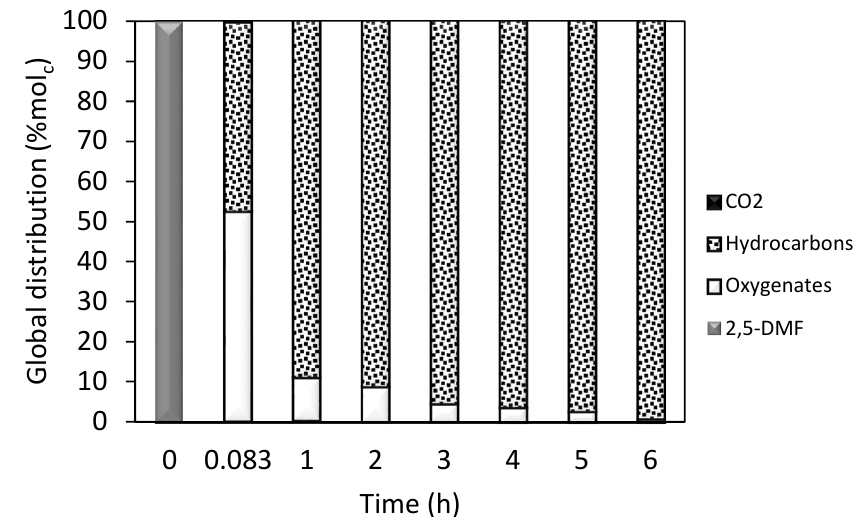
Figure 9. Carbon global distribution as a function of time during the 2,5-dimethylfuran (2,5-DMF) transformation on the SI–(Ru–Pt)/S40 bimetallic catalyst.